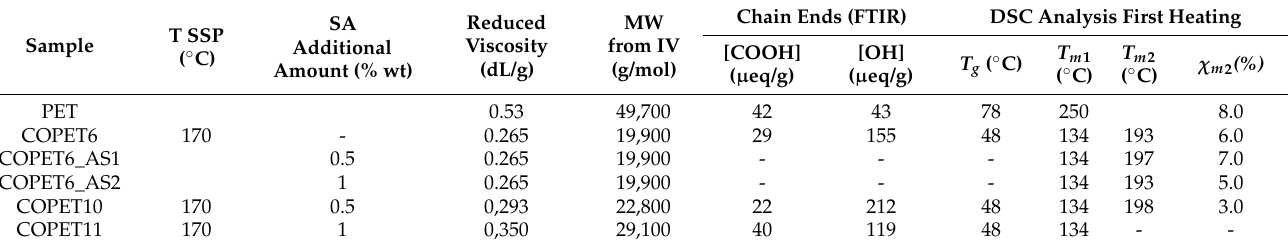
Table 4. Effect of additional SA on SSP of